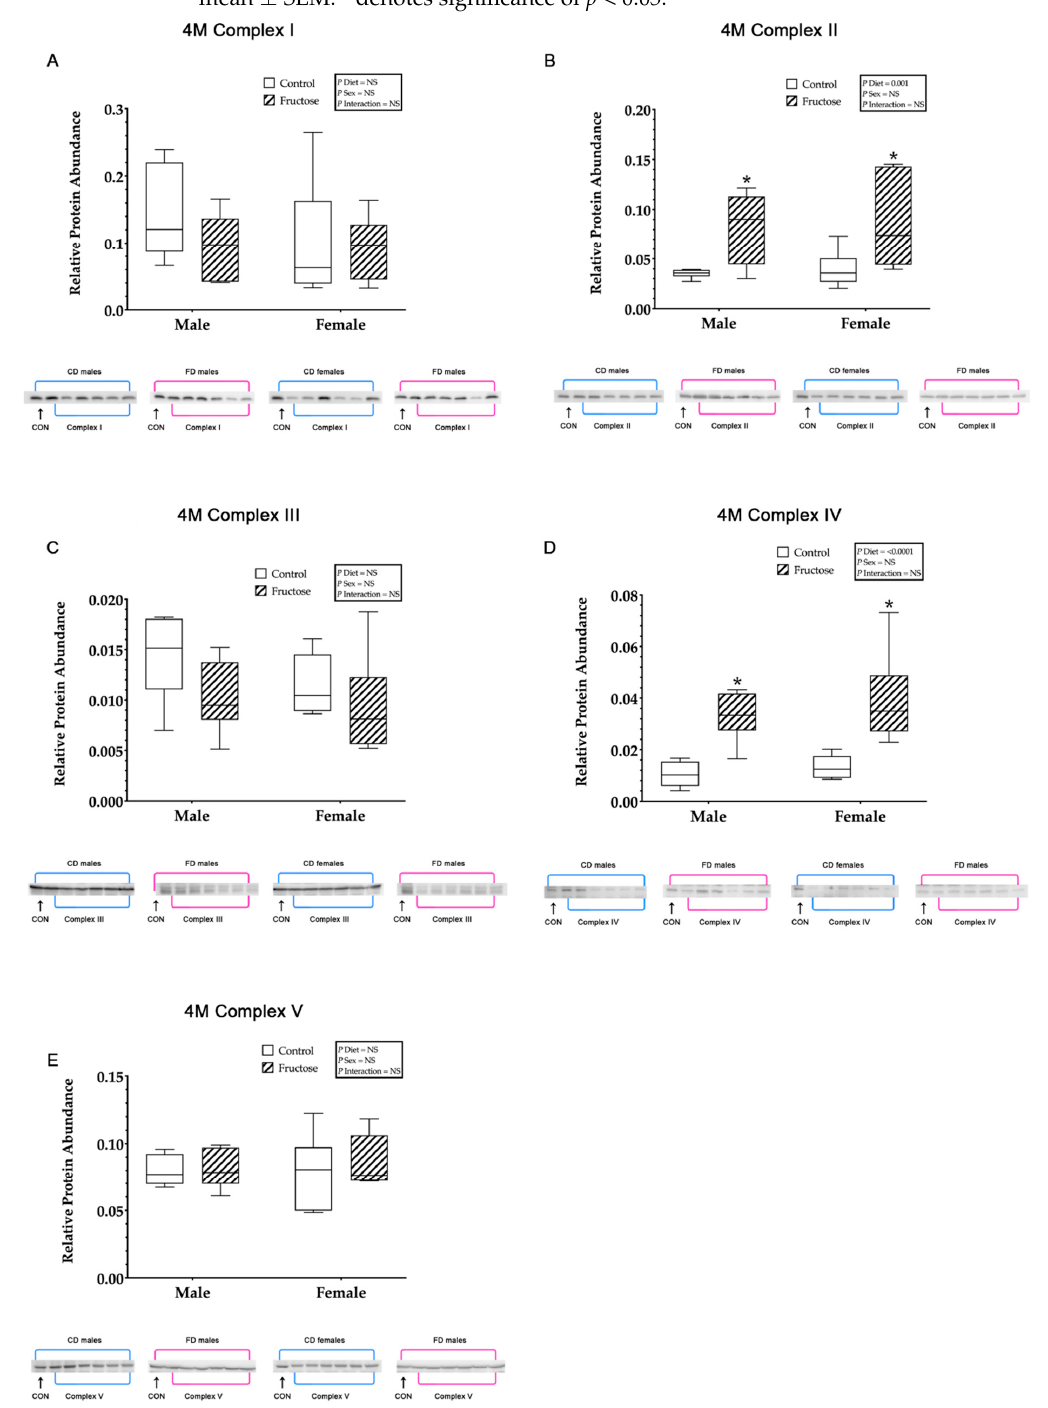
Figure 4. ( A – D ) Adult offspring control males ( n = 6); fructose males ( n = 6); control females ( n = 5) and fructose females ( n = 6). ( A ) Represents adult offspring hepatic mitochondrial complex-I